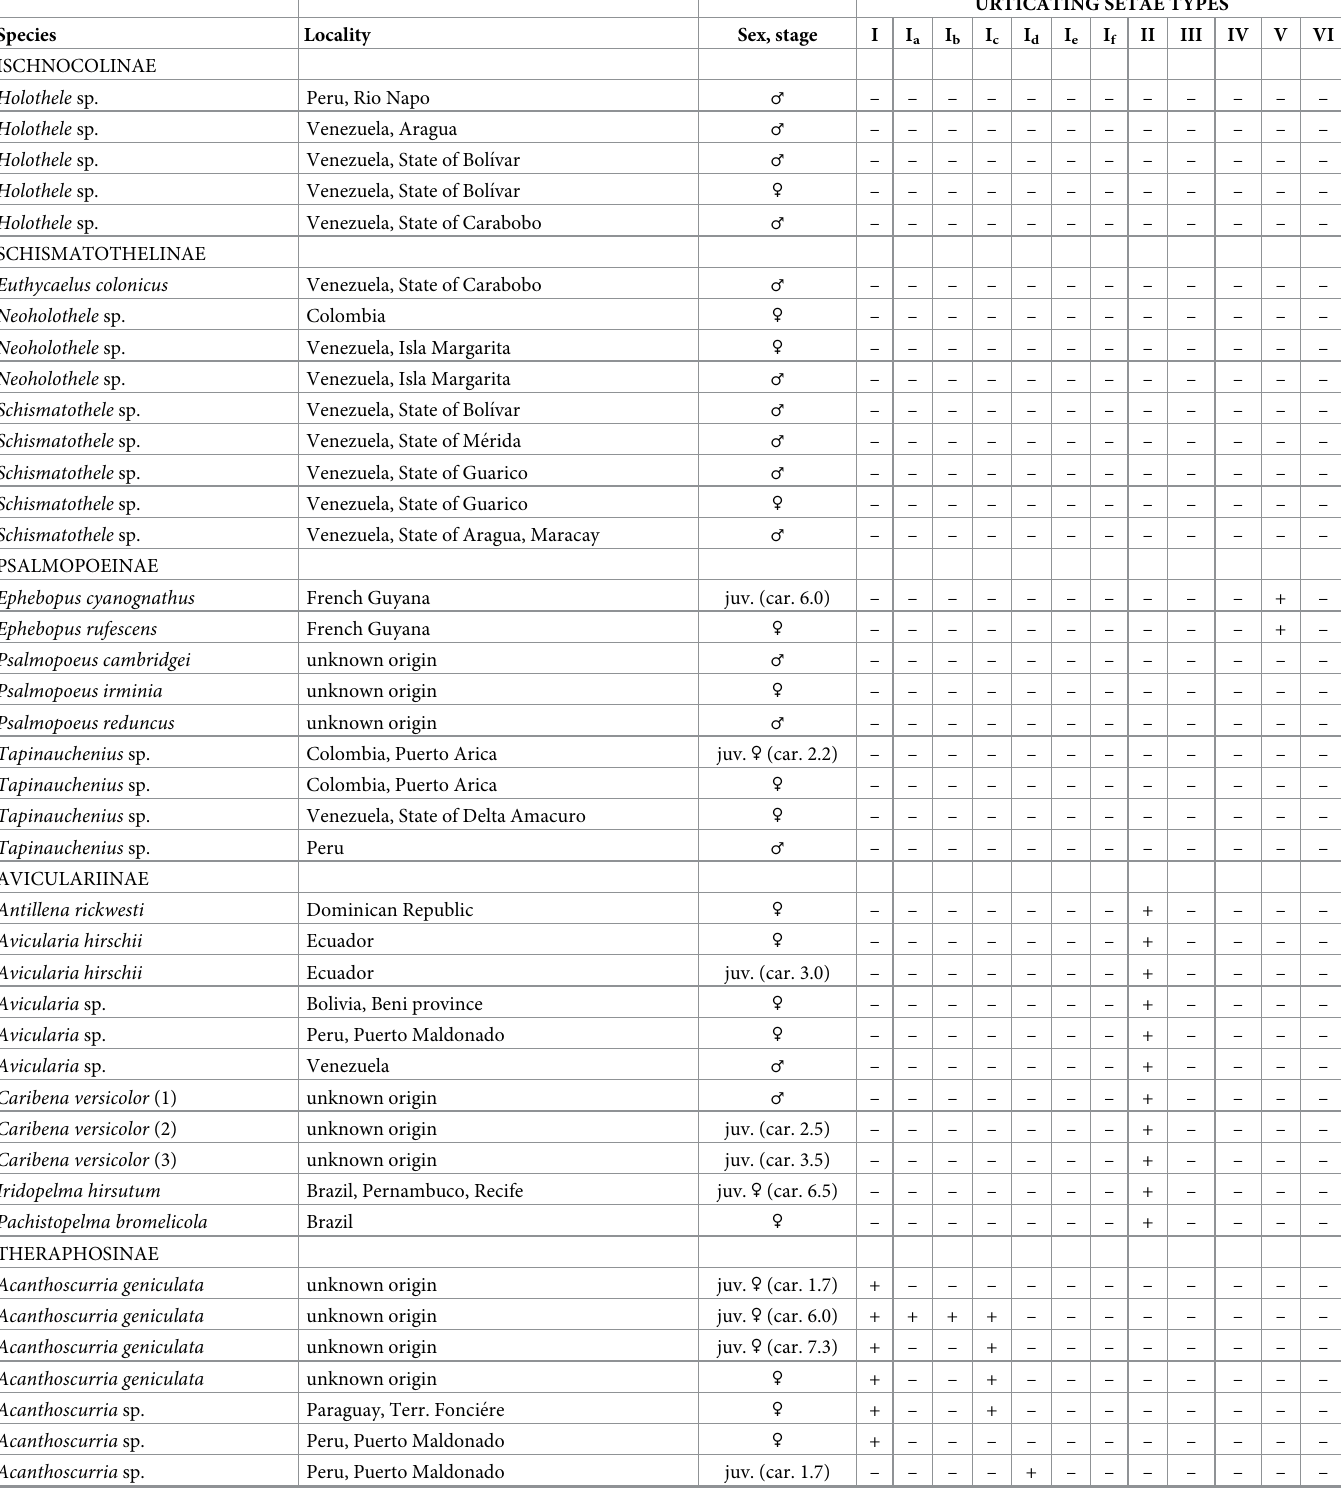
Table 14. Distribution of urticating setae types in studied